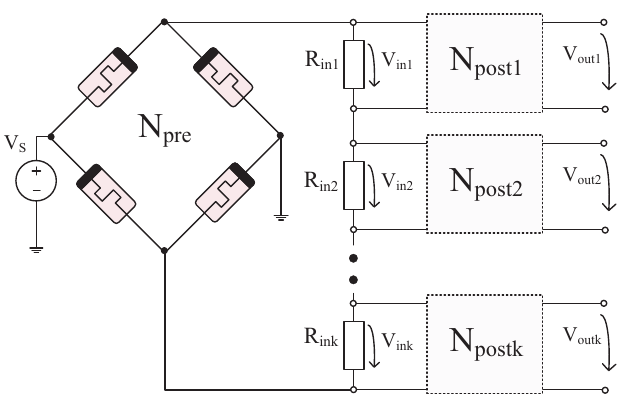
Fig. 13 : Schematic of a presynaptic neuron which is con- nected to several postsynaptic